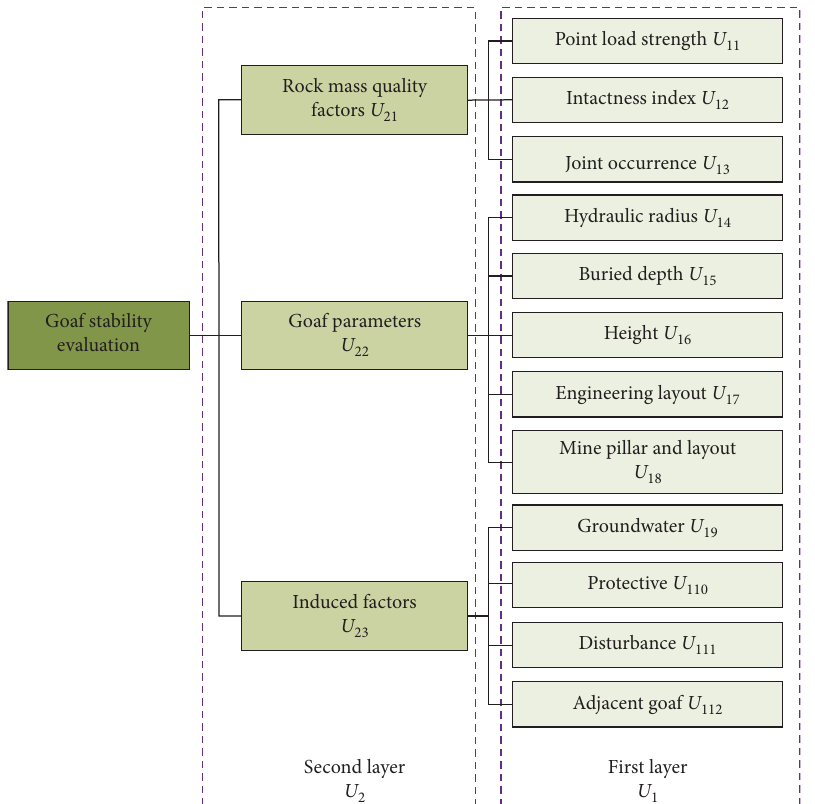
Figure 1: Two-layer fuzzy comprehensive evaluation mathematical